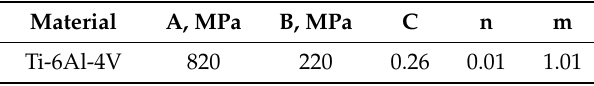
Table 1. Parameters of the model used in the simulation